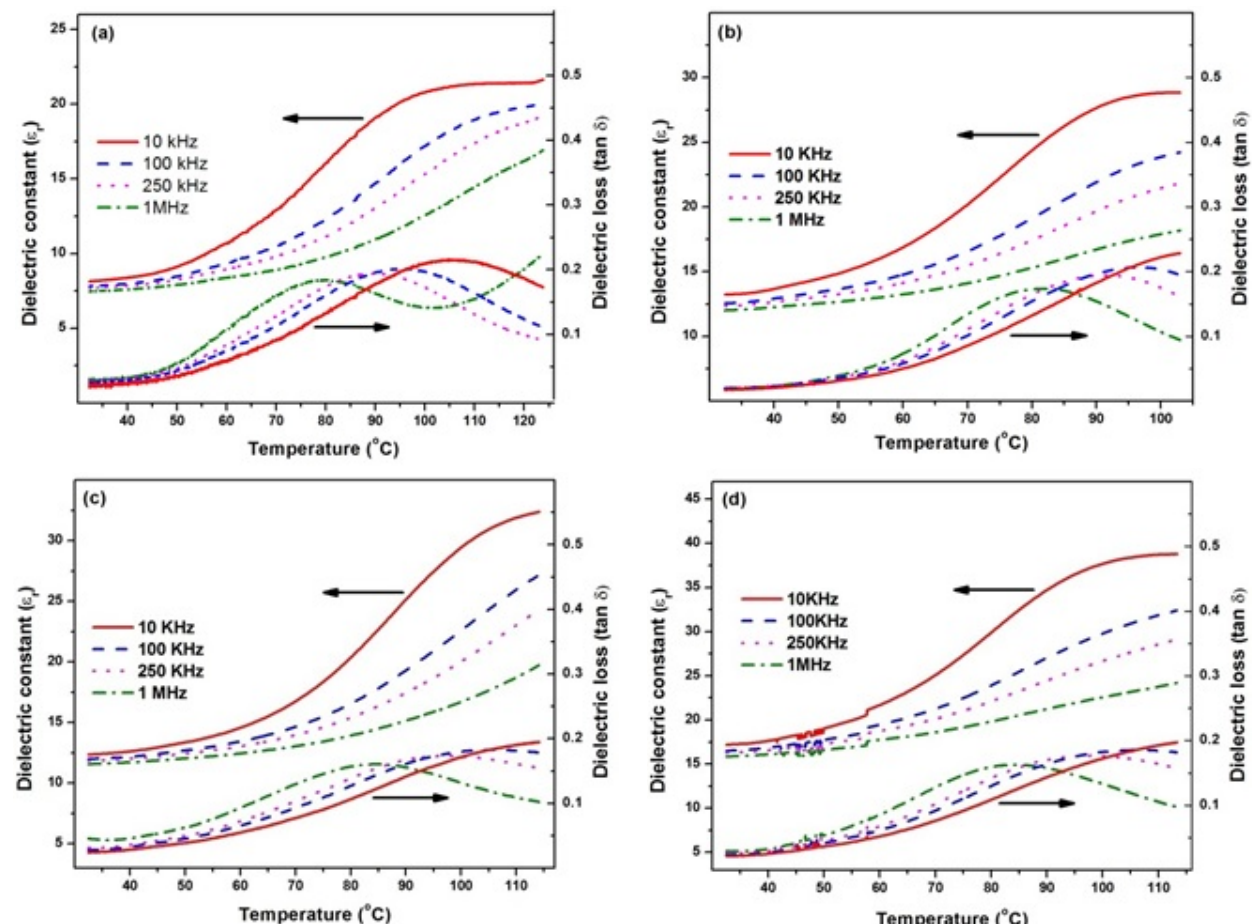
Figure 5. Temperature and frequency dependence of ε r and tan δ for various BT content in PVC matrix. ( a ) 0%, ( b ) 10%, ( c ) 20%, ( d ) 30%.